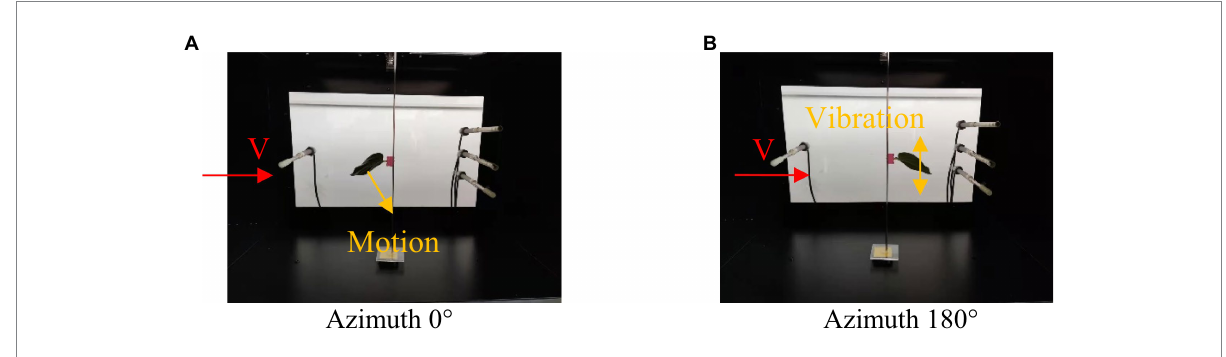
FIGURE 10 Motion of leaves at different airflow velocities, V , and azimuth angles, φ . (A) Azimuth 0 ° . (B) Azimuth 180 °